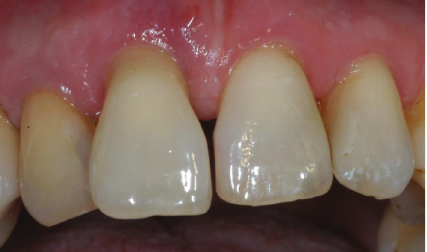
Figure 1: The right-maxillary central incisor was considerably extruded. The patient complained of mobility and slight localized pain during function.